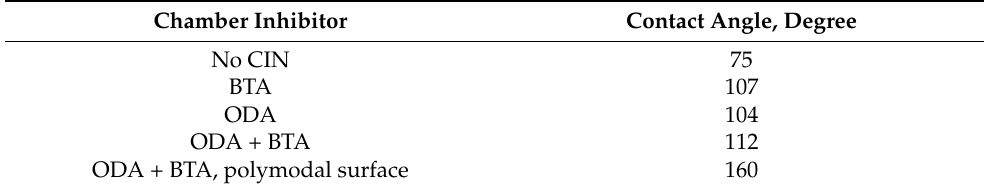
Table 7. Effect of copper CT on the contact angles of wetting with distilled water. T CT = 100 ◦ C, and τ CT = 60